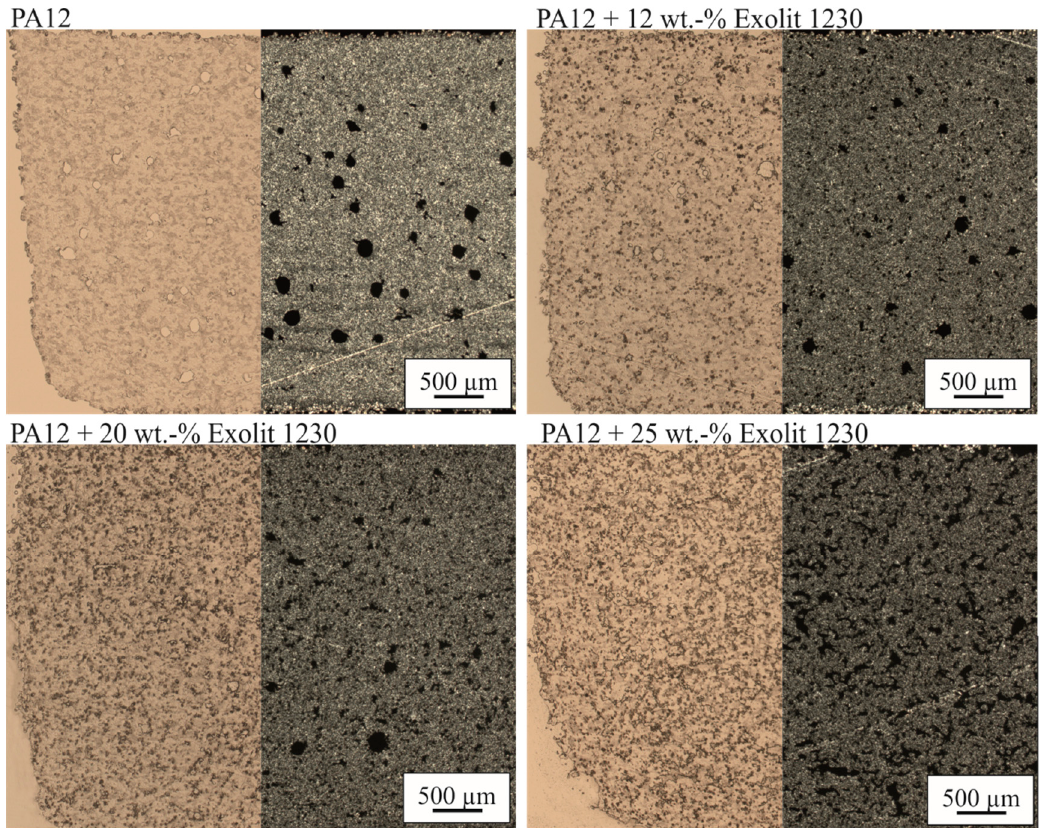
Figure 9. Microscopy images (bright field and polarized light) of the laser-sintered tensile test specimen for different flame retardant concentrations and an energy density of 0.35 J/mm³.